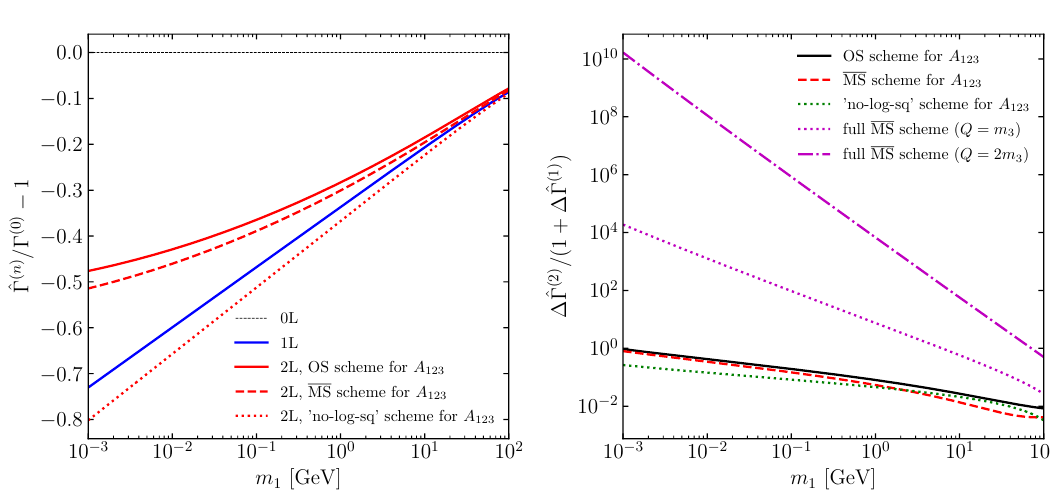
Figure 7. The one- and two-loop external φ 3 leg corrections to the φ 3 → χ ¯ χ decay width as a function of m 1 . In the left plot the one- and two-loop results for the decay width are shown relative to the tree-level result, while in the right plot the two-loop corrections are shown relative to the one-loop result. We have chosen m 2 = m 3 = 1 TeV, y 3 = 1 , A 123 = 3 TeV, while the other trilinear couplings are set to